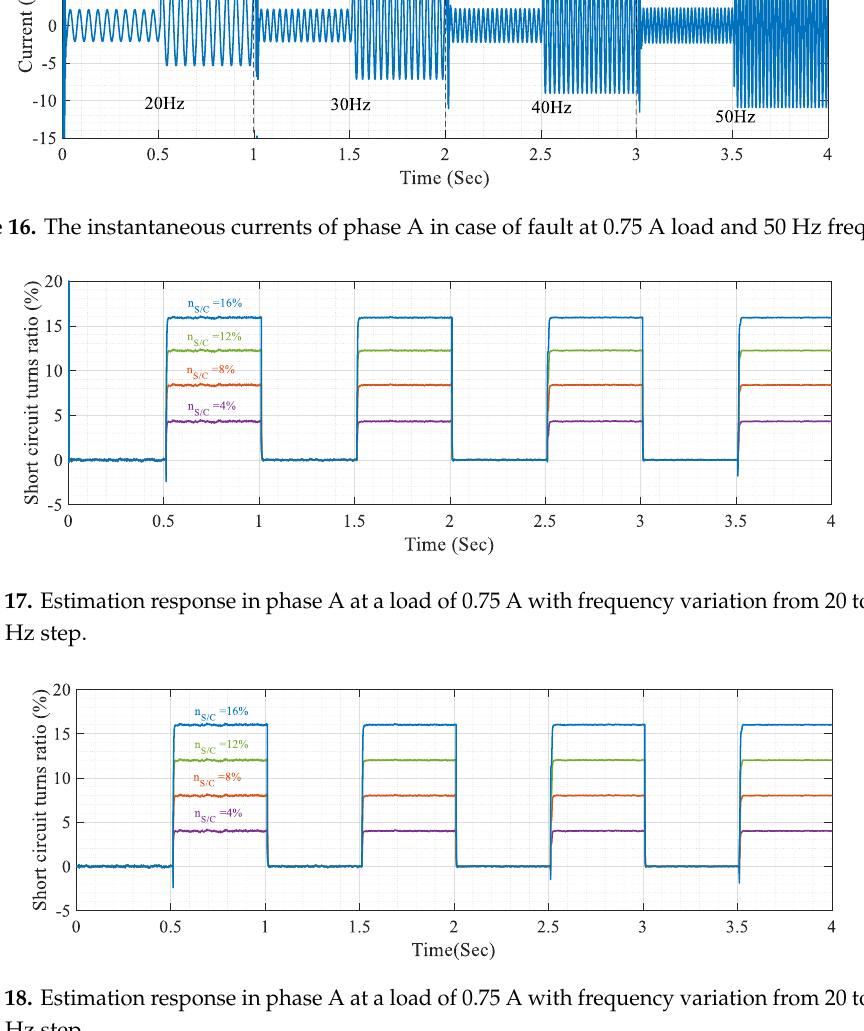
Figure 18. Estimation response in phase A at a load of 0.75 A with frequency variation from 20 to 50 Hz and 10 Hz step.